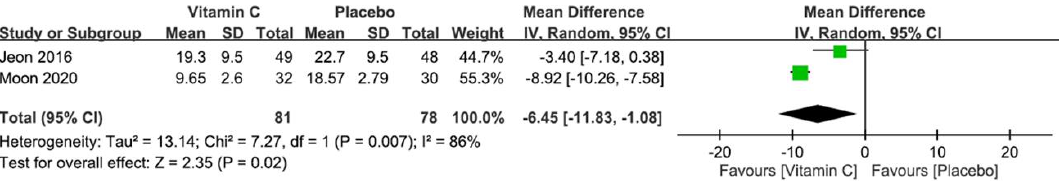
Figure 8. Forest plot for the comparing opioid consumption (mg) within 6 h after surgery between vitamin and placebo groups. CI, confidence interval; IV, inverse variance; WMD, weighted mean difference.